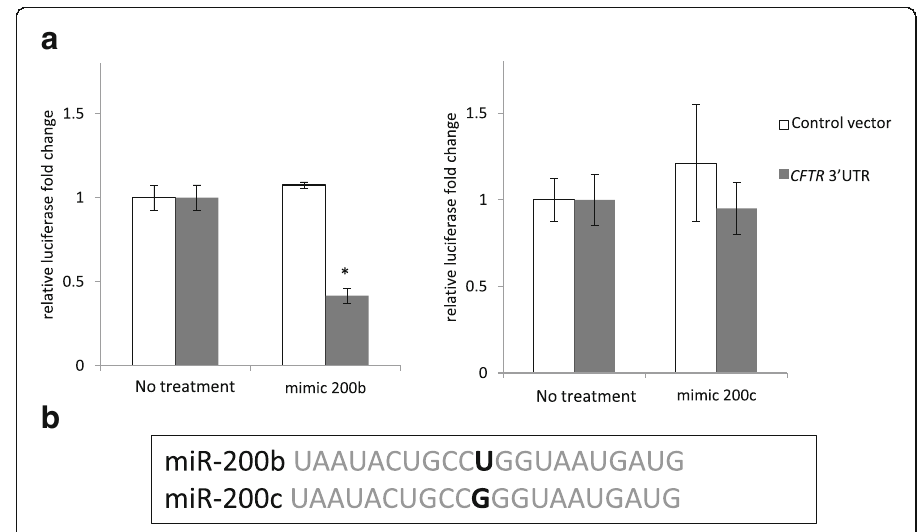
Fig. 4 miR-200b binds to the predicted target sequence in the CFTR 3 ′ UTR. a HEK293 cells were transfected with 3 ′ UTR CFTR luciferase reporter construct alone (white) or together with miR-200b mimic (grey, left panel) or miR-200c mimic (grey, right panel). Similar experiments were performed on control vector that did not contain the miR-200b/miR-200c target site (not shown). Data were normalized to control Renilla lu- ciferase activities from 2 independent experiments ( n = 6) and are expressed as a fold-change over control. Error bars represent standard deviations (SD). Significant changes ( P < 0.05) are marked with an as- terisk. b The comparison of miR-200b and miR-200c seed sequences is